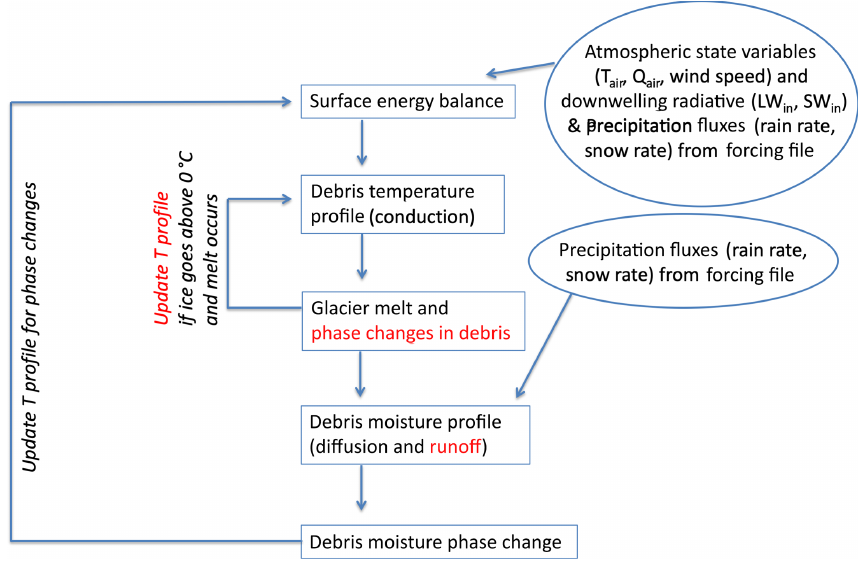
Figure 4. Flow of the processes in the ISBA-DEB model. The red text indicates major changes introduced to the ISBA code in the creation of ISBA-DEB. Table A1 contains physical constants and model parameters used for the runs on West Changri Nup glacier.